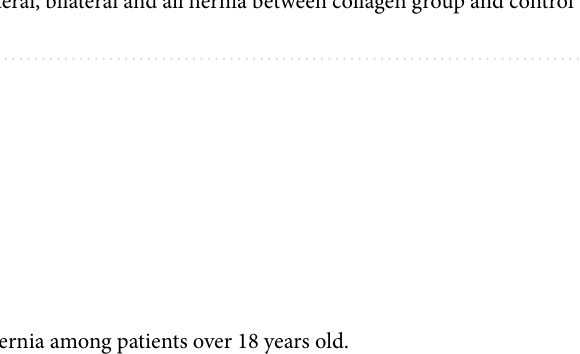
Table 4. Multivariable analysis for risk of hernia among patients over 18 years